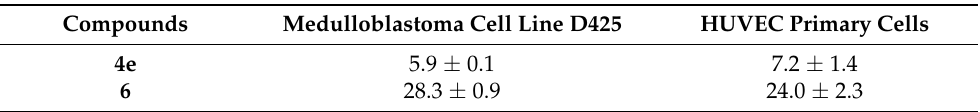
Table 3. TD 50 values (in µ M) of selected compounds tested in malignant and nonmalignant human cells by MTT